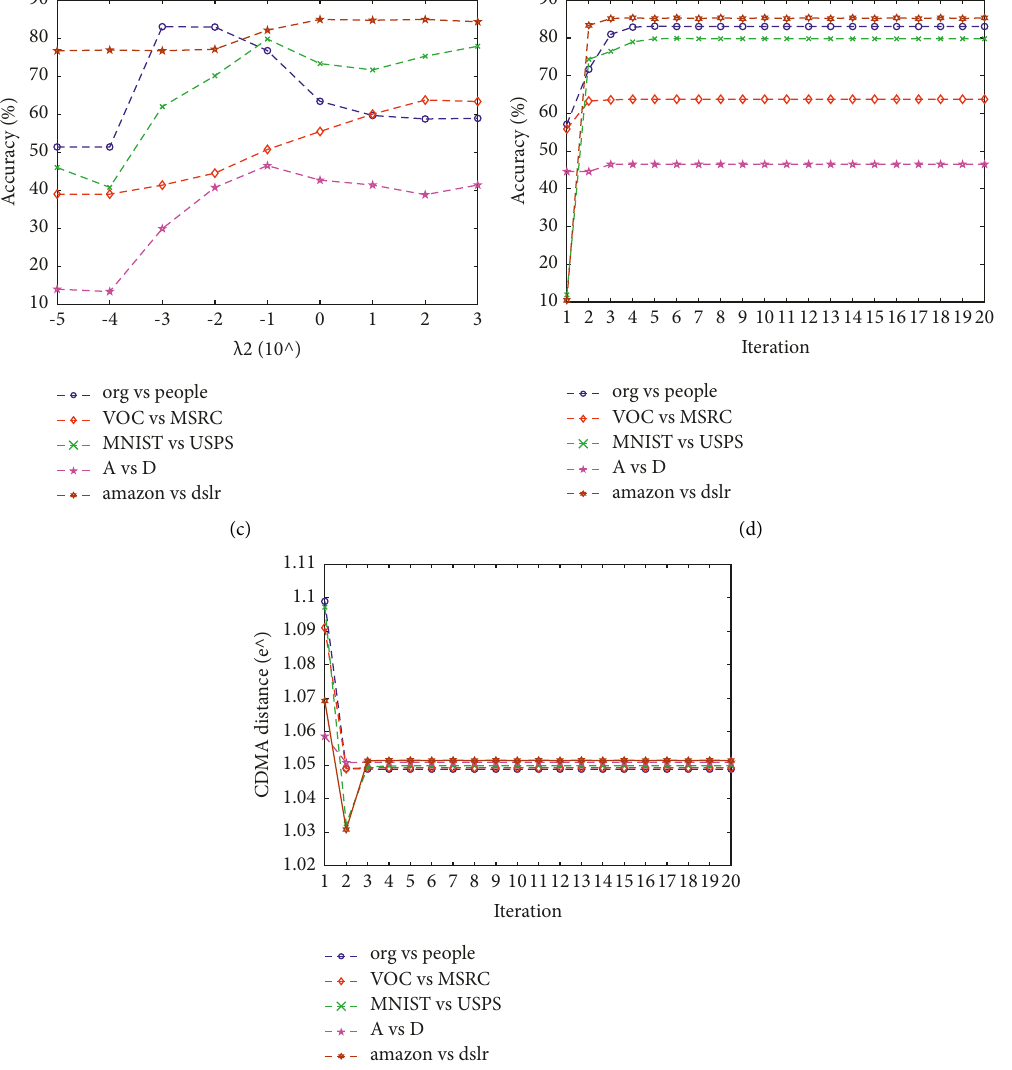
k 1 , α k 2 , and λ 2 on the accuracy of